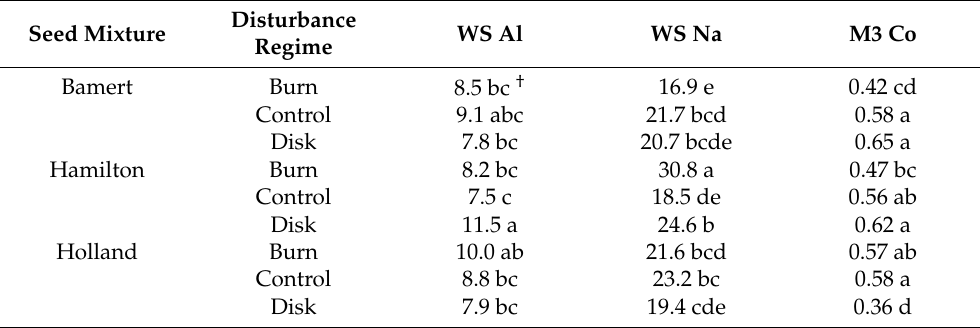
Table 1. Measured soil properties organized by pollinator mixture and disturbance regime at the Natural Resources Conservation Service Plant Materials Center in Booneville, AR in 2016 and 2017. Disturbance Seed Mixture